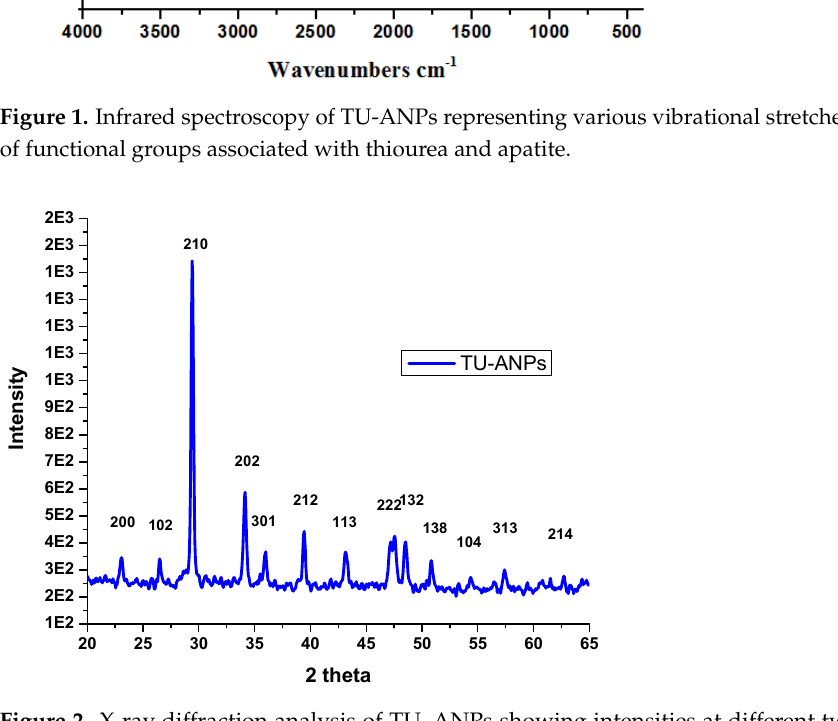
Figure 2. X-ray diffraction analysis of TU–ANPs showing intensities at different two theta levels matching a standard spectra of apatite with JCPDS: 00-009-0432.